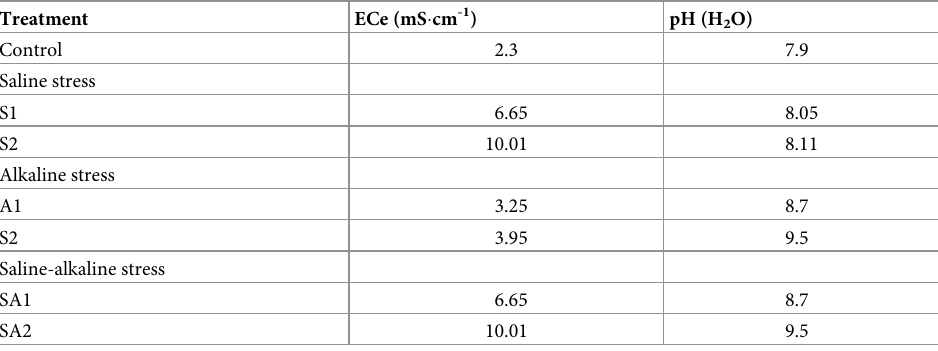
Table 1. The ECe and pH value of soil in different saline and alkaline stress treatments.